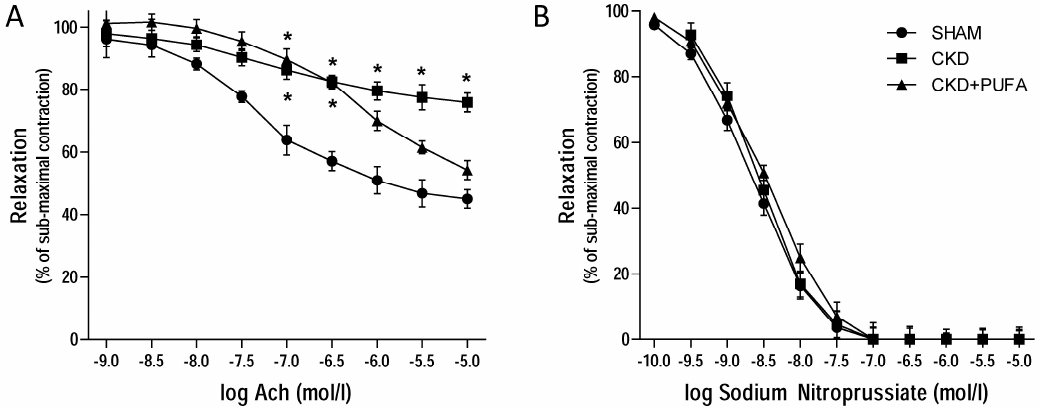
Figure 1. ( A ): Concentration response curves to acetylcholine (ACh) in sham-operated (SHAM), 5/6 nephrectomized rats fed with standard diet (CKD) and fed with n 3-PUFA enriched diet (CKD + PUFA). Vascular reactivity studies were performed on segments of thoracic aortas from each group. n = 10/group; ( B ): Concentration response curves to Sodium Nitroprussiate in the same groups. n = 10/group. Submaximal contraction to phenylephrine (10 − 6 mol/L) was similar among groups. * p < 0.05 vs. other groups.